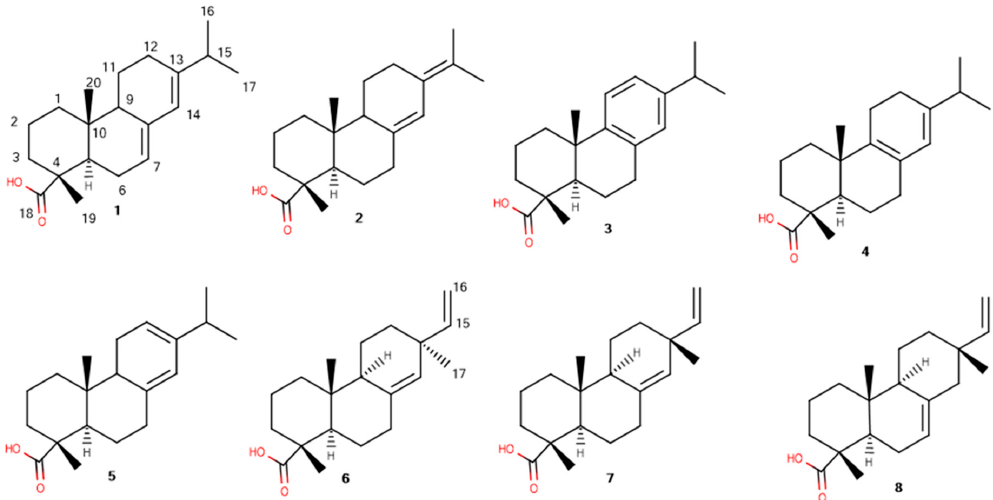
Figure 1. The structures and numbering of the diterpenic resin acids of the Pinus nigra heartwood